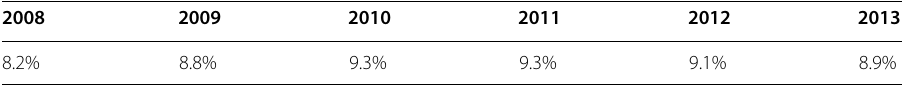
Table 2 Water output elasticity over the